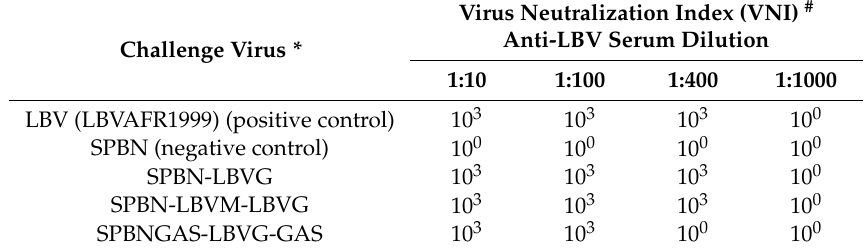
Table 2. Neutralization of recombinant viruses with the different dilutions of the anti-Lagos bat virus serum as determined by the rapid fluorescent focus inhibition test (RFFIT).